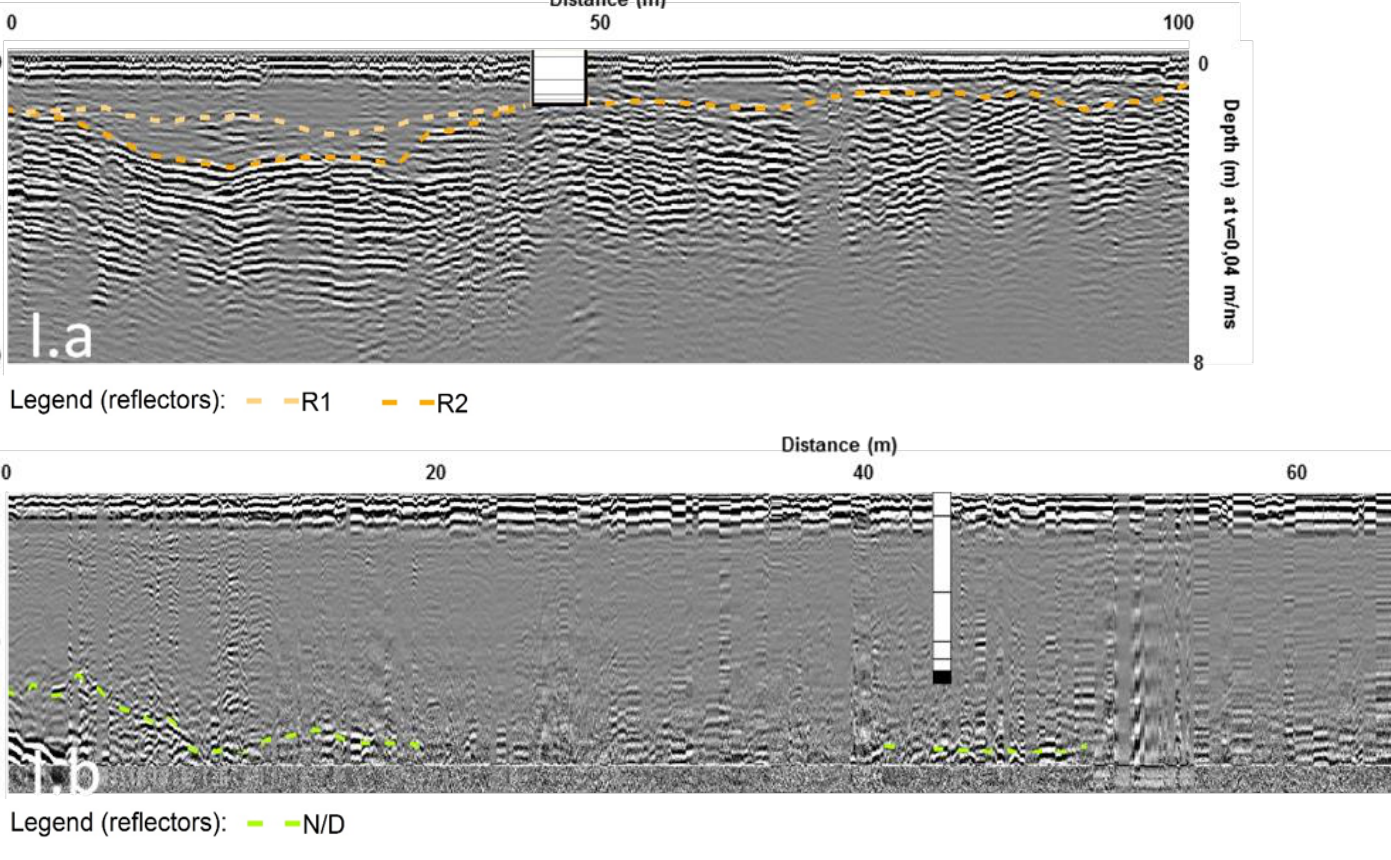
Figure 7. Peat Bog I: example radargrams produced using the 100 MHz antenna (above) and the 500 MHz antenna (below). The transect selected includes the open core (see Figure 4 for more information). The dashed lines indicate interpreted reflections in the GPR